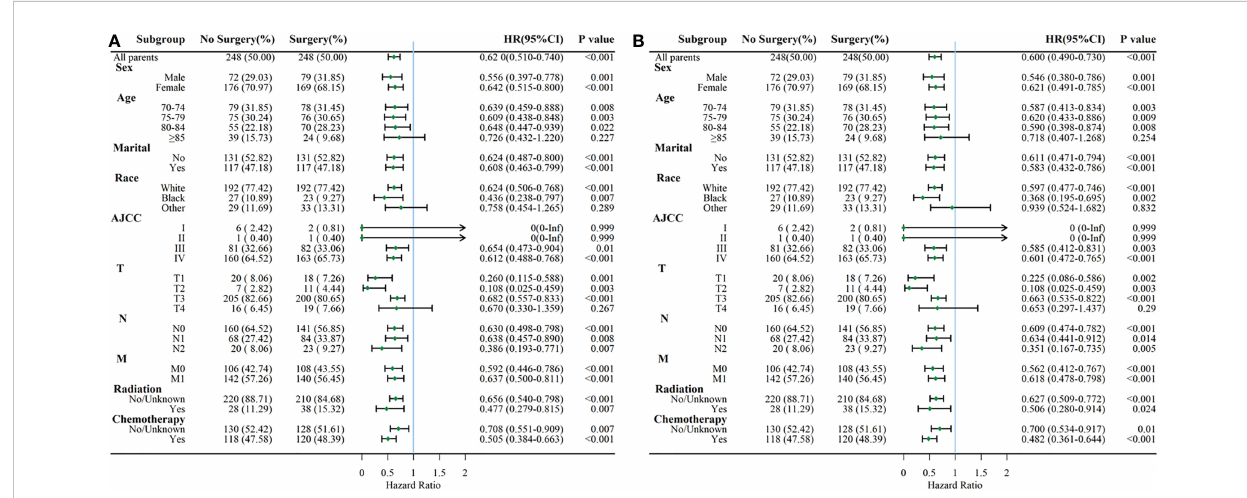
FIGURE 4 Subgroup analysis comparing OS (A) and CSS (B) between surgery and no-surgery order GBC